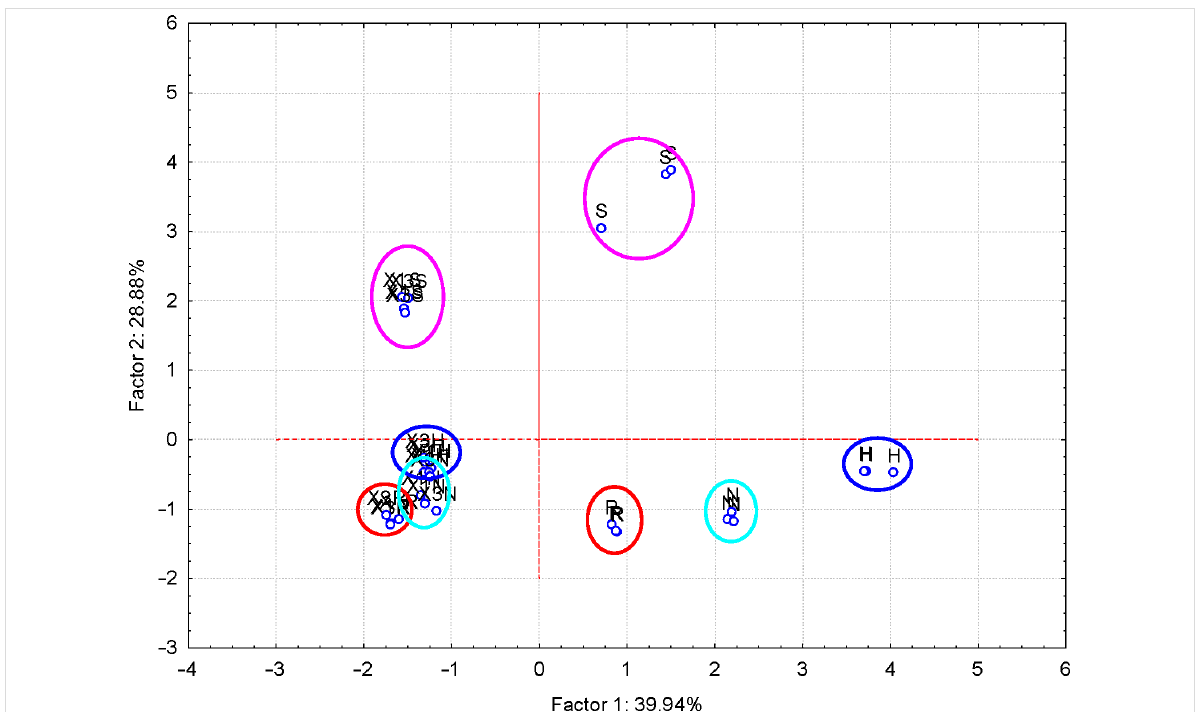
Figure 7: PC 2 versus PC 1 scores plot from the FTIR–PCA analysis of the β -CD/hazelnut oil/flavonoid ternary complexes (codes: “X1H/N/R/S” and “X3H/N/R/S” for the 1:1:1 and 3:1:1 ternary complexes with hesperidin/naringin/rutin/silymarin, respectively) and flavonoids (codes: “H” – hesperidin, “N” – naringin, “R” – rutin and “S” – silymarin); only wavenumbers of the FTIR bands were used as input variables.